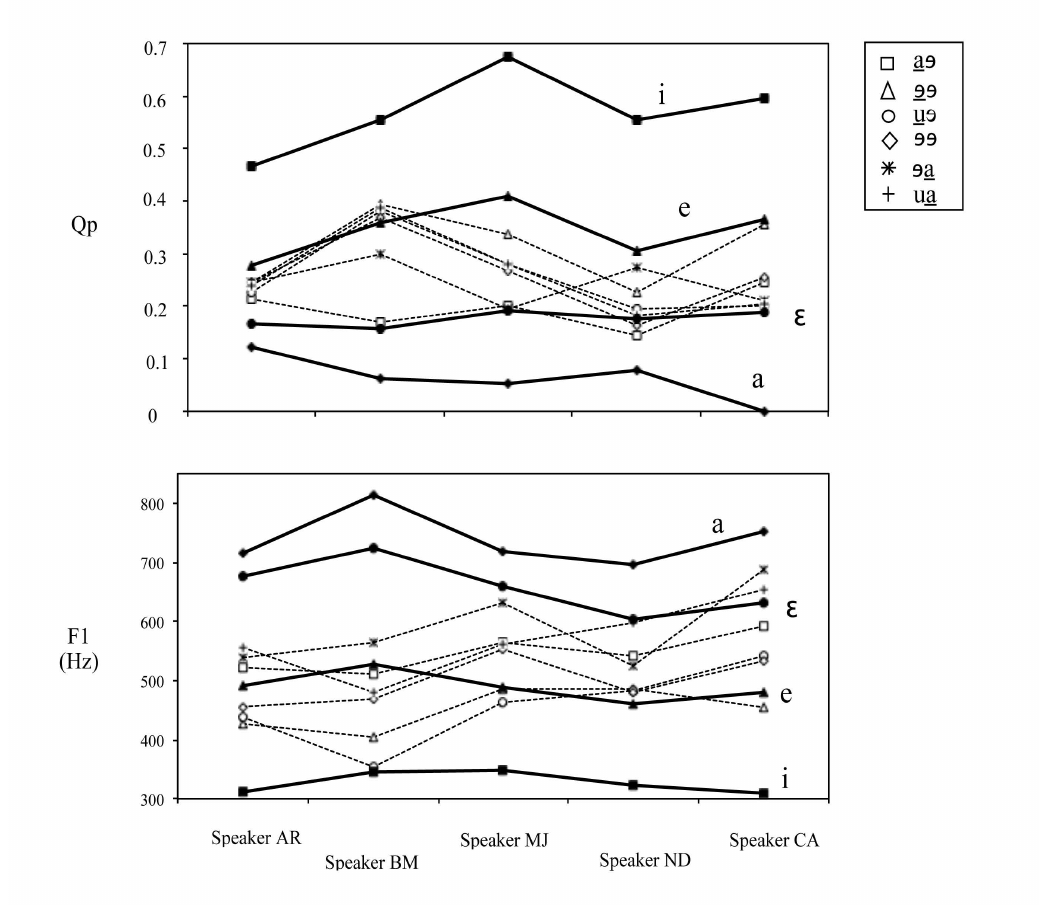
FIGURE 4. Qp (top) and F1 (bottom) values for intervocalic [j] in the vowel sequences [  a  ,  ,  u  ,  ,  a, u  a] and for the vowels [i, e,  , a] according to the Majorcan Catalan speakers AR, BM, MJ, ND and CA. Stressed vowels appear underlined in the vowel sequences of